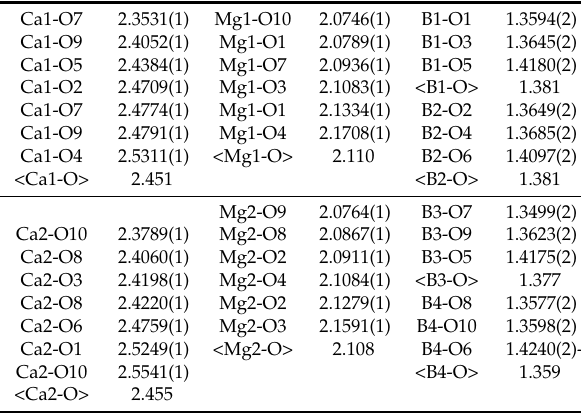
Table 6. Selected bond lengths (Å) for the crystal structure of